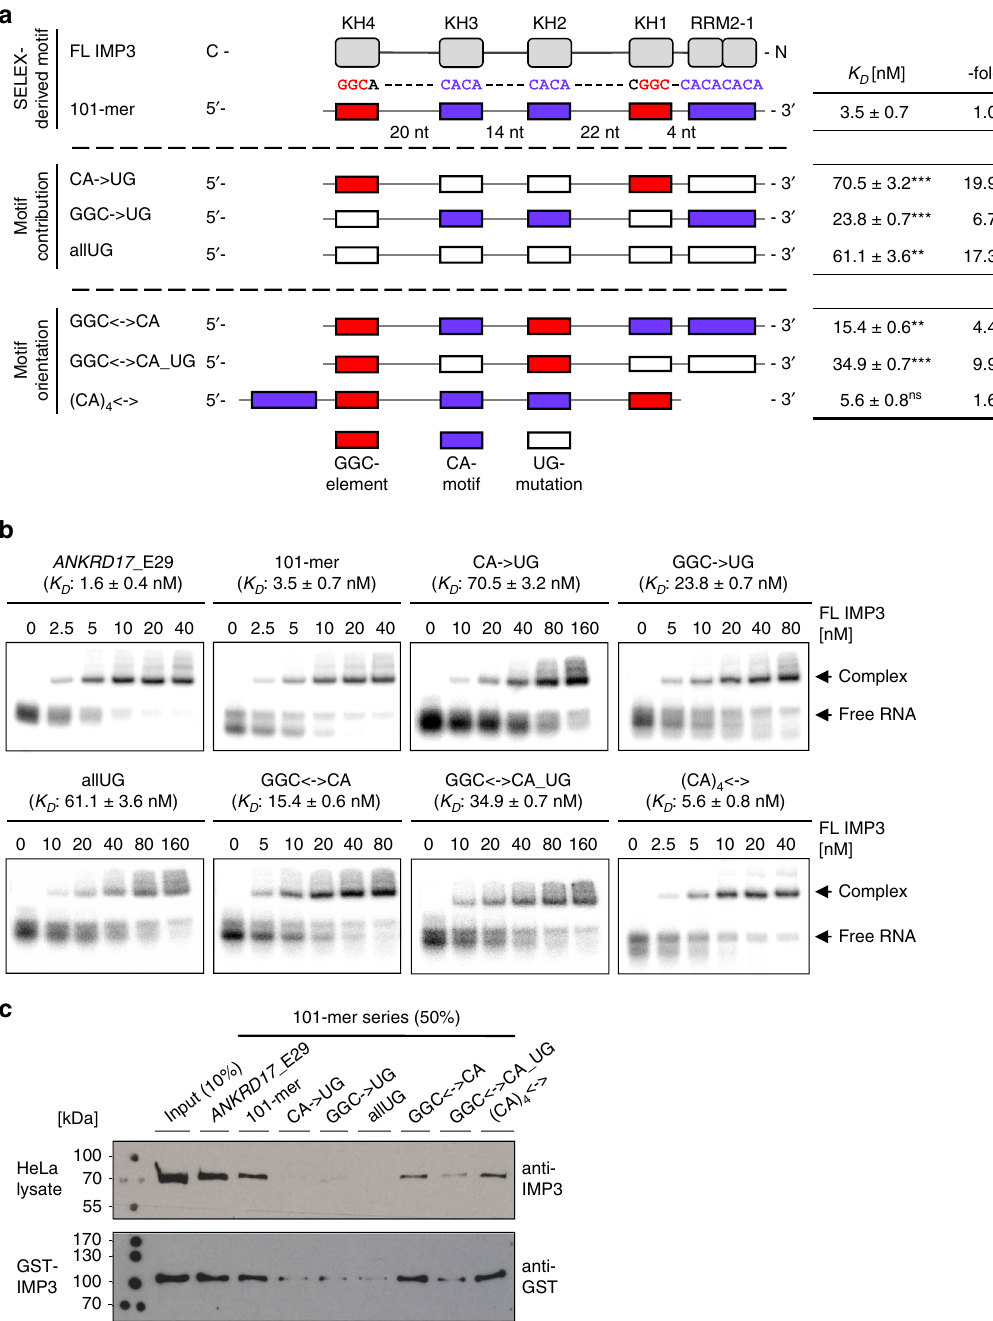
Fig. 3 Validation of the SELEX-derived array of IMP3-binding motifs: mutational analysis. a Design of a 101-mer RNA, containing all SELEX-derived IMP3- binding motifs (GGC motifs, red boxes; CA motifs, violet boxes) with appropriate spacing and serving as a basis for mutational analysis and validation assays. The IMP3 domains potentially interacting with the respective sequence elements of the 101-mer RNA are indicated (top). The contributions of speci fi c motifs were tested by mutational analysis (CA motifs or GGC-core elements or both of them mutated to UG, middle). The importance of motif orientation was analyzed by shuf fl ing of domain-speci fi c sequence motifs (KH1 – 2-speci fi c motifs: GGC<->CA; additional substitution of the CA motifs: GGC<->CA_UG; relative positioning of the RRM1 – 2-speci fi c motif: (CA) 4 <->, bottom). K D values obtained by electromobility shift assays